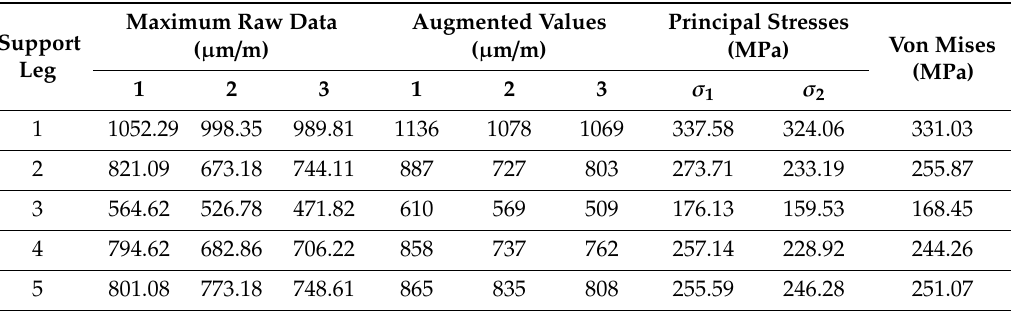
Table A2. Computational